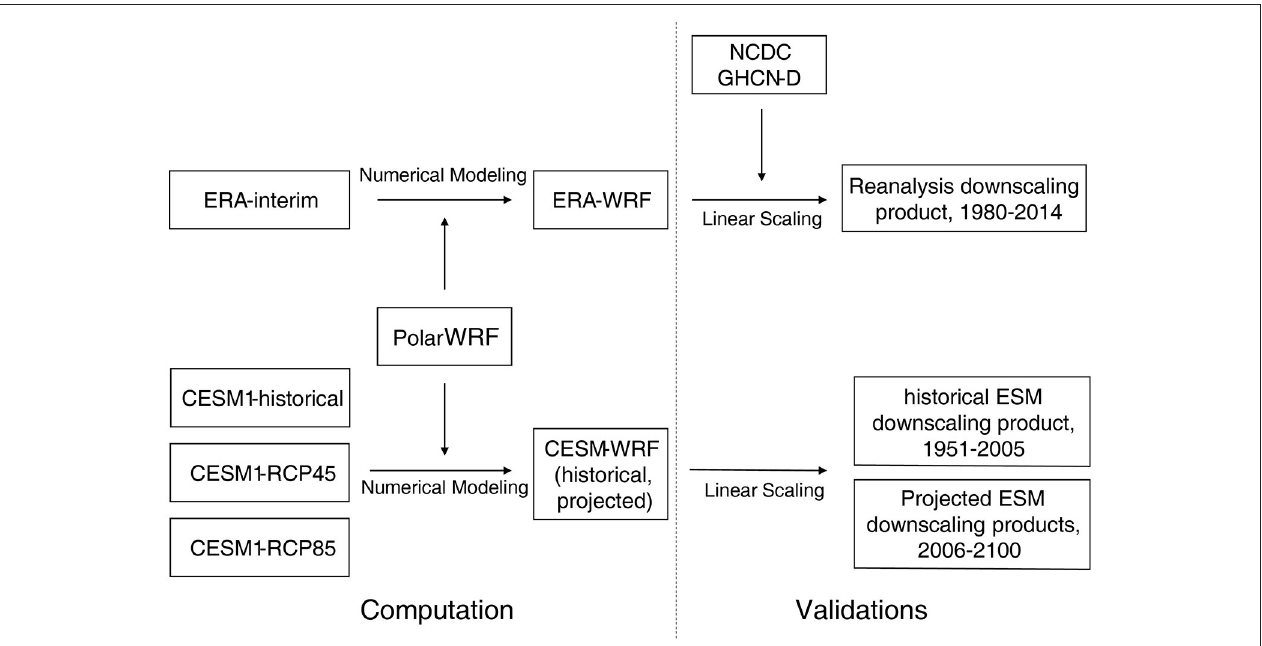
FIGURE 2 | The flowchart indicating the steps involved in developing the three downscaling products.